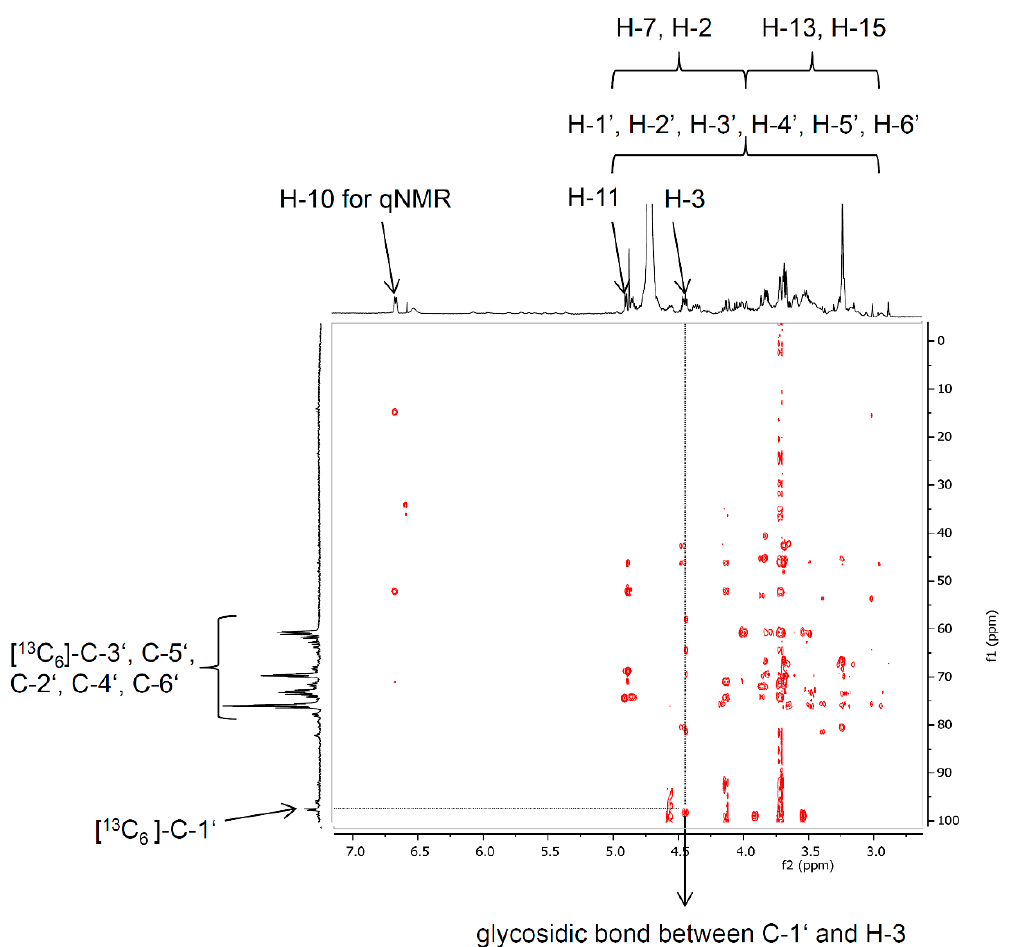
Figure 4. Section of the HMBC NMR spectrum of [ 13 C 6 ]-D3G showing indicating the glycosidic bond of 13 C-1 ′ from [ 13 C 6 ]-glucose to H-3 of DON.